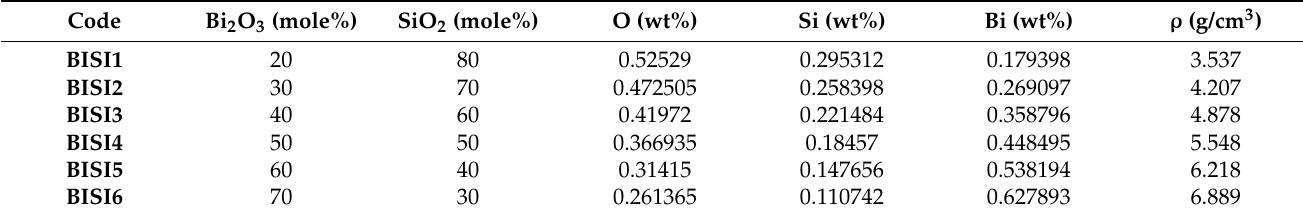
Table 1. Samples codes, chemical composition, elemental compositions and density ( ρ ) of glass samples.